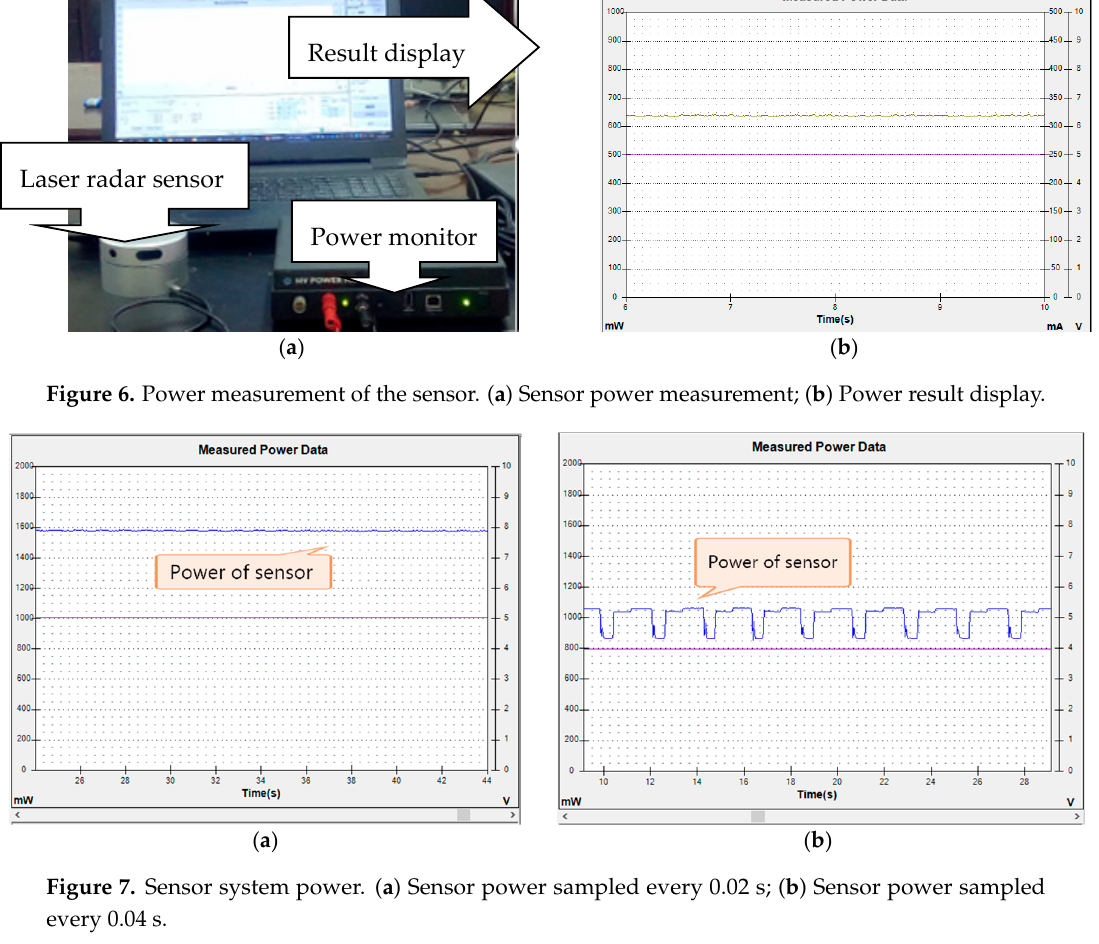
Table 2. Sensor power comparison between model and measurement.